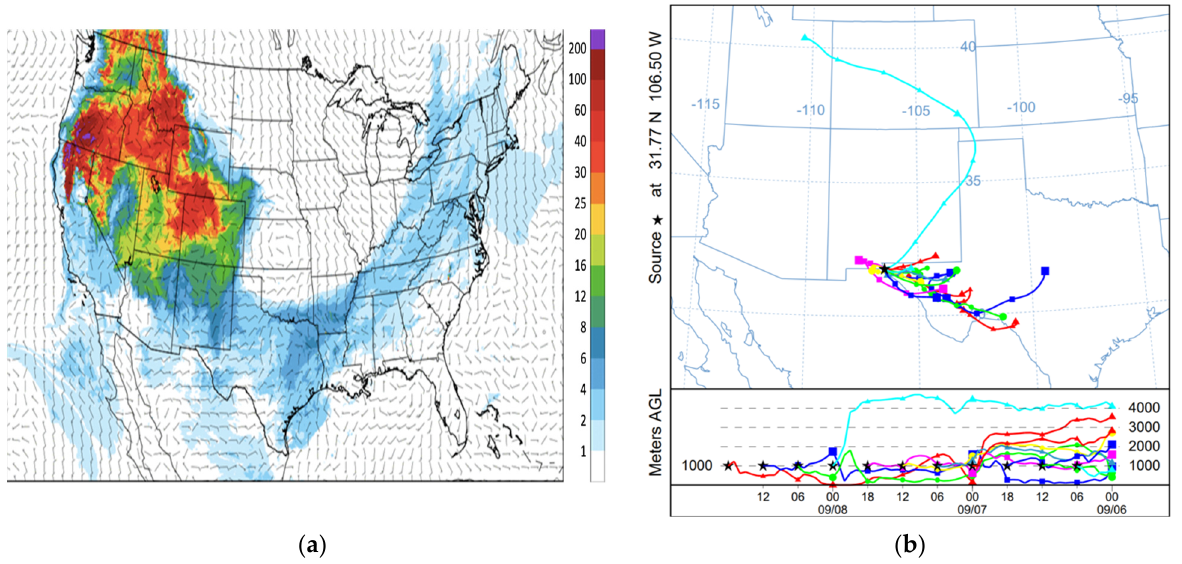
Figure 12. The HRRR and HYSPLIT analyses for 8 September 2021. ( a ) The HRRR map indicates the surface mass concentration, from purple at the origin of the wildfire (northern California and south Oregon) to light blue at its lowest concentrations. El Paso, located at the western corner of the state of Texas received 2 to 8 micrograms per cubic meter of PM 2.5 . ( b ) The HYSPLIT backward trajectories run for 72 h at height 1, 1.5 and 2 km from the surface.